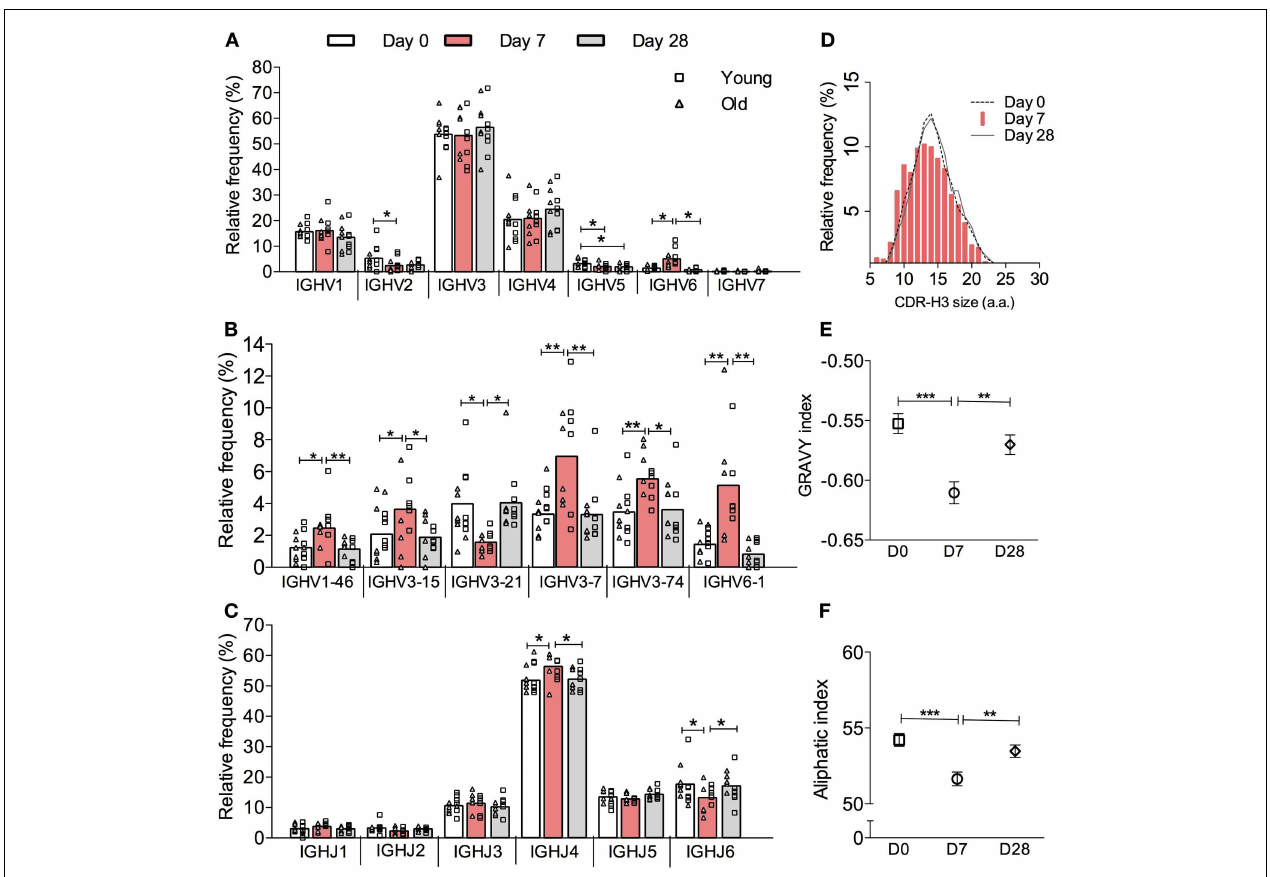
Bars indicate MEAN. (D) CDR-H3 virtual spectratypes, showing the relative frequency ( y -axis) of a particular CDR-H3 size ( x -axis in amino acid numbers) within the whole CDR-H3 repertoire, was calculated using all clonotypes from 12 donors at D0 (dotted line), D7 (red bars), and D28 (solid line).The GRAVY and aliphatic indices for each CDR-H3 peptide was determined by ProtParam.The overall GRAVY (E) and aliphatic (F) indices all clonotypes from 12 donors were compared by Kruskal–Wallis comparisons with Dunn’s post-test between D0 (squares), D7 (circles), and D28 (diamonds). Error bars indicate ± SEM. * p < 0.05, ** p < 0.005, and *** p < 0.0005.